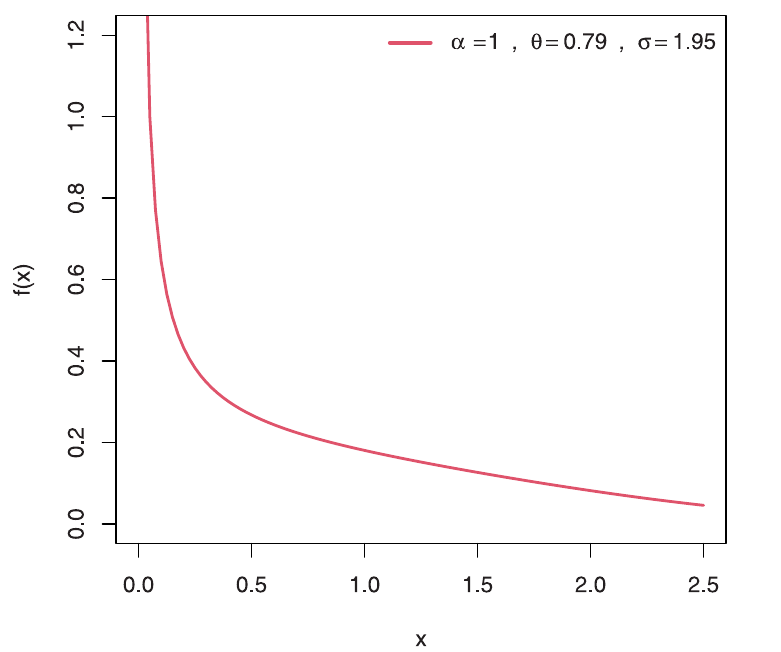
Fig 1. Plots of EGuNH density for a variety of parameter combinations.